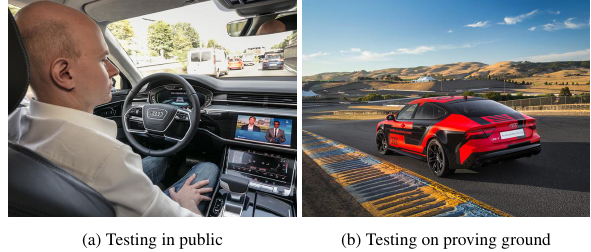
Figure 2. Vehicle-in-the-Loop testing in real environments 1